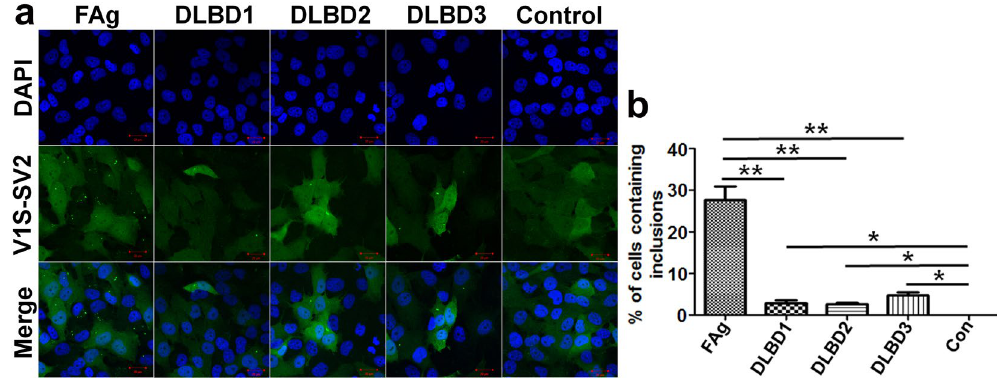
Figure 8. The comparison of seeding activity of α S seeds from human brain and in vitro recombinant α S. (a) H4/V1S-SV2 cells were treated with 0.1 µ g α S from IP/ α S products isolated from amygdala of 3 patients with DLBD (DLBD1, DLBD2 and DLBD3) and 1 age-matched control (Control), and an aliquot of FAg for 2 days followed by imaging under confocal microscopy. Scale bar: 20 µ m. (b) The bar graph shows the comparison of the ratio of cells with inclusions to total cells among all